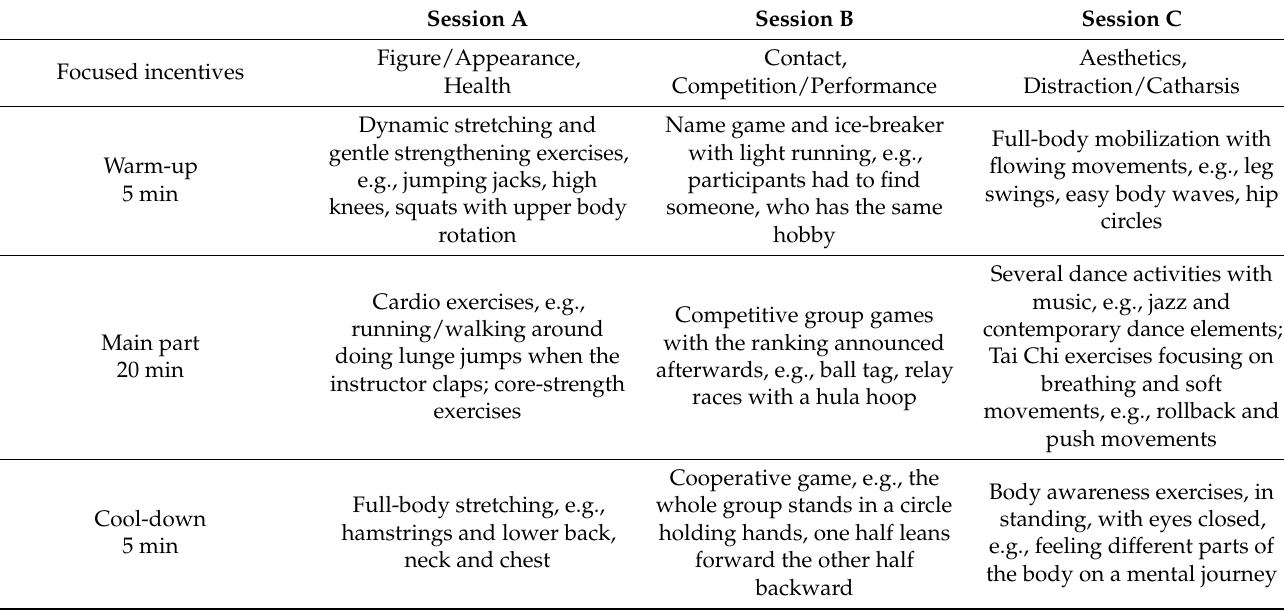
Table 1. Structure and content of the three exercise trial sessions.